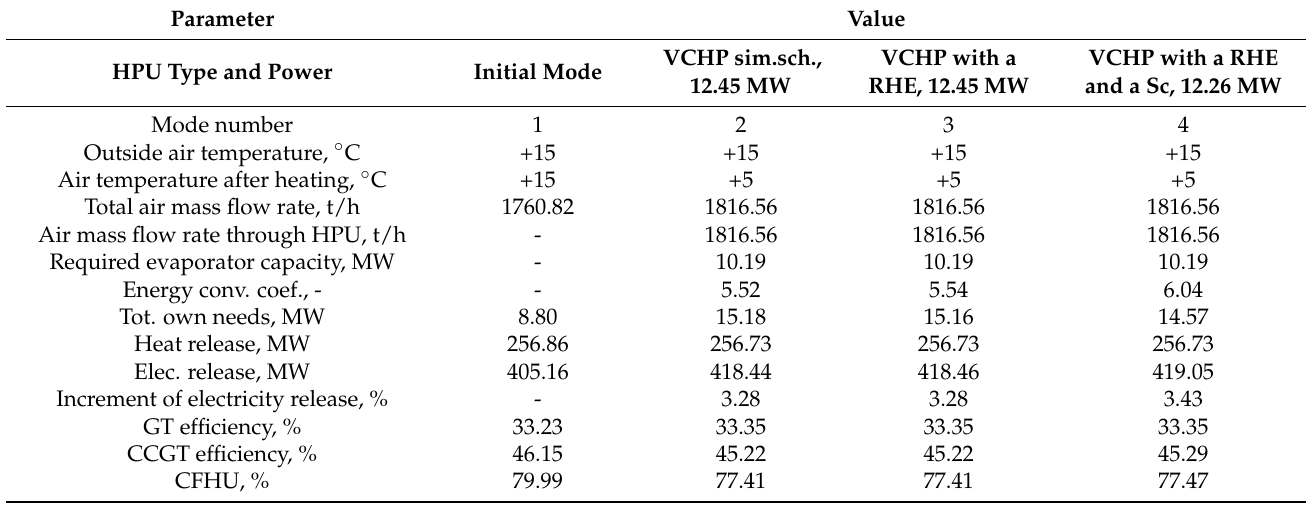
Table 10. Summer modes simulation results of using VCHPs for cooling the intake